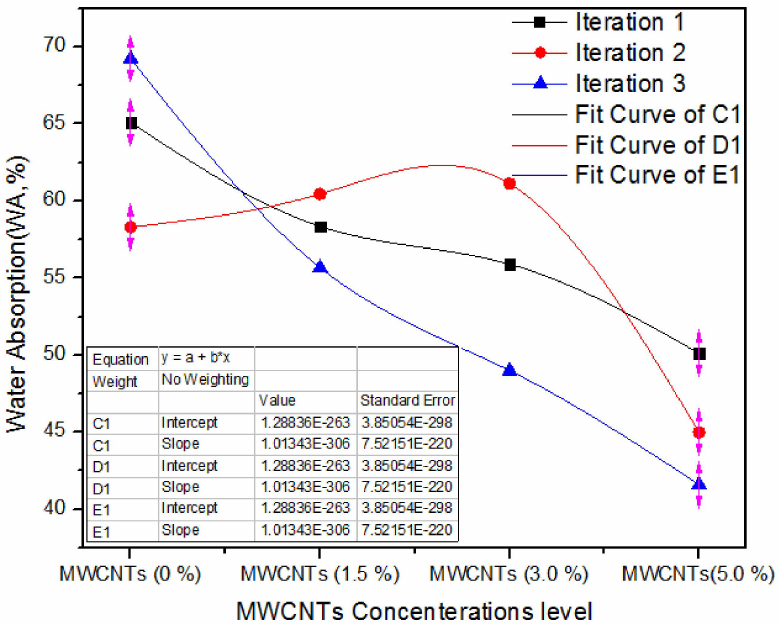
Figure 9. Water absorption of numerous counts of